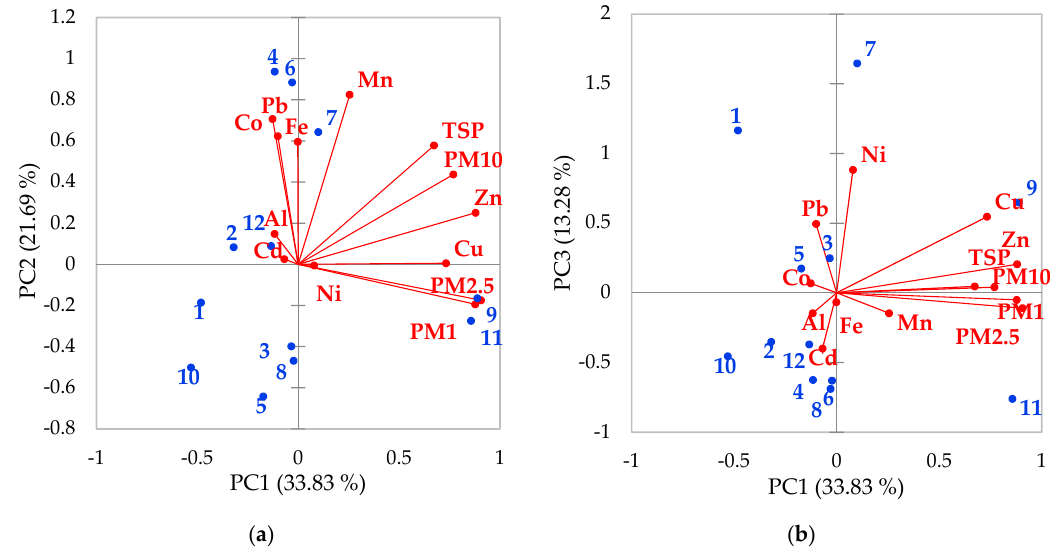
Figure 6. PCA biplots representing both observations (sampling sites) and variables (metal content in poplar leaves and PM concentration in air): ( a ) PC1–PC2, ( b )